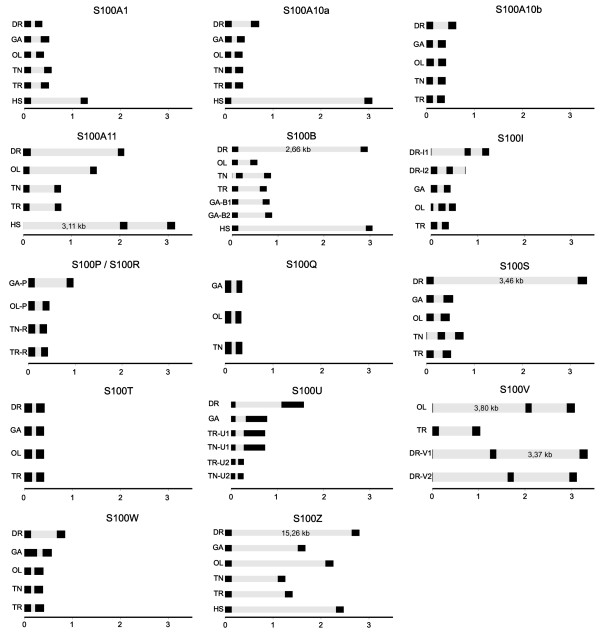
Genomic structure of 66 teleost fish s100 genes. Predicted exon/intron structure is drawn to scale (kb units) for all s100 genes with genomic sequence information: fourteen genes each for zebrafish (Dr; Danio rerio) and takifugu (Tr; Takifugu rubripes), thirteen genes each for medaka (Ol; Oryzias latipes) and stickleback (Ga; Gasterosteus aculeatus), twelve genes for tetraodon (Tn; Tetraodon nigroviridis). Exons are represented by black filled rectangles and introns are represented by the gray boxes connecting the exons. Where present, the human ortholog is drawn for comparison (Hs, Homo sapiens).